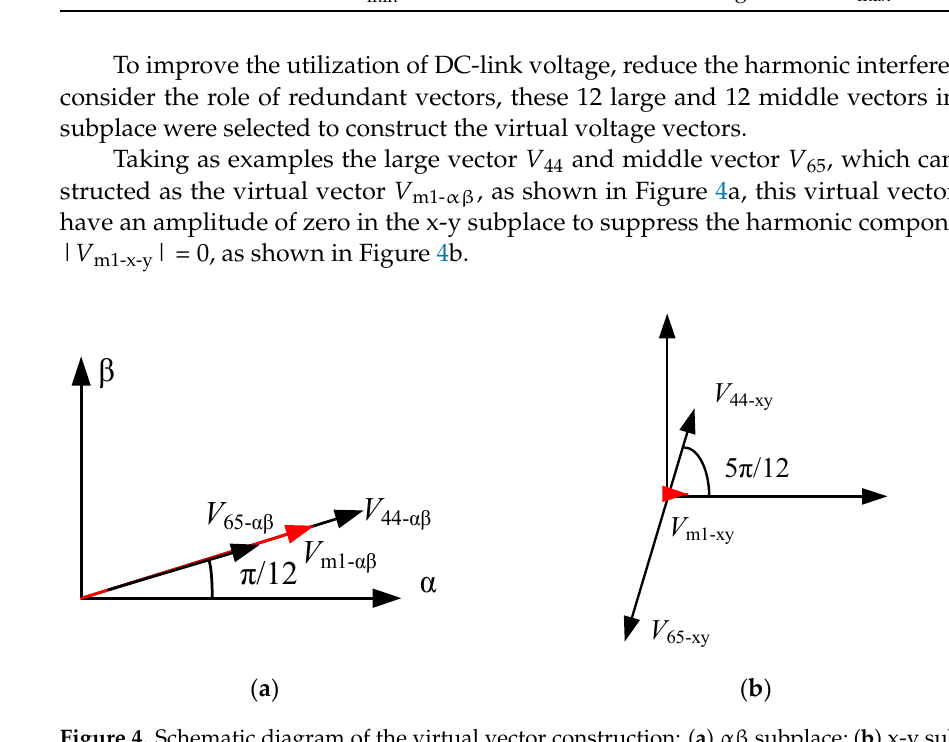
Figure 4. Schematic diagram of the virtual vector construction: ( a ) αβ subplace; ( b ) x-y subplace.